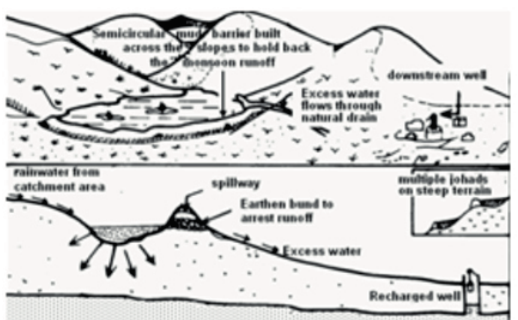
Fig. 3 Rainwater harvesting using johads (adapted from Kishore 2003).